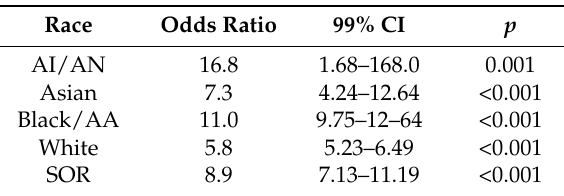
Table 4. The odds ratio effect modification by race on the association between total cholesterol and BMI in children.